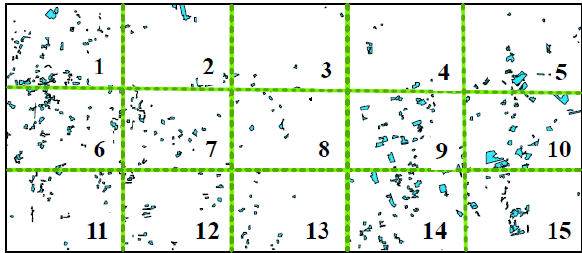
Figure 4. Tile references and deforestation polygons.